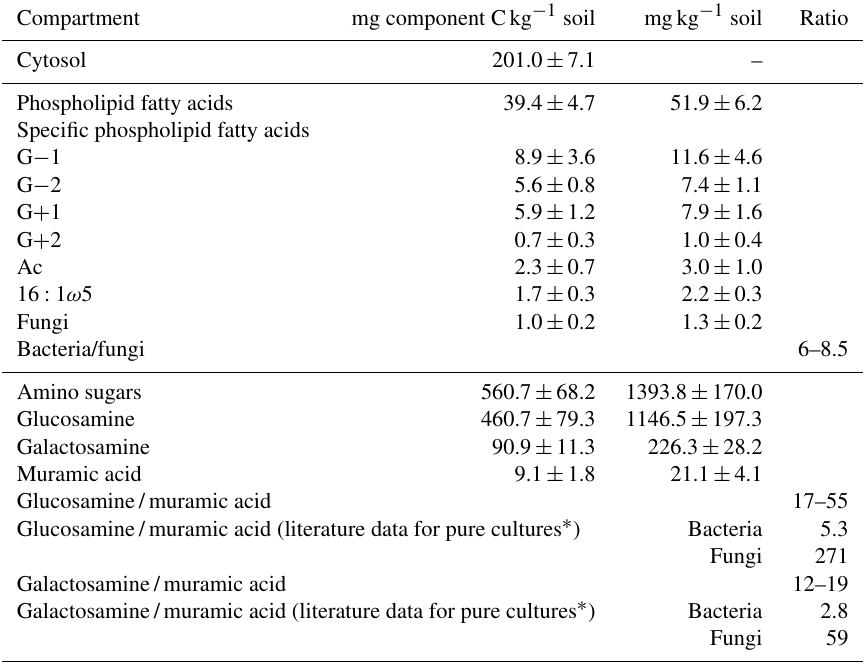
Table 1. Amount of microbial biomass compartments, their C content, PLFA content of microbial groups and composition of microbial residues in investigated soil. G − 1 and G − 2 are Gram-negative group one and two, respectively; G + 1 and G + 2 are Gram-positive group one and two, respectively; Ac – actinomycetes; 16 : 1 ω 5 – saprotrophic fungi. Data present mean of three time points (with four replications for each time point) ±